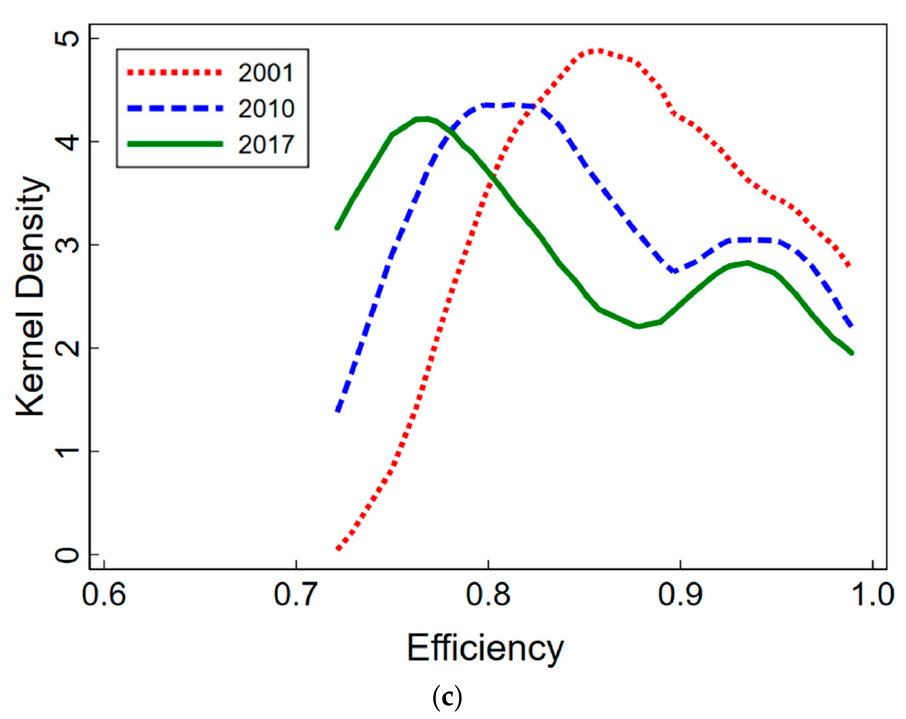
Figure 4. The trend of crop water use efficiency in Liaoning Province. ( a ) Crop growth water use efficiency. ( b ) Crop ecological water use efficiency. ( c ) Crop production water use efficiency.